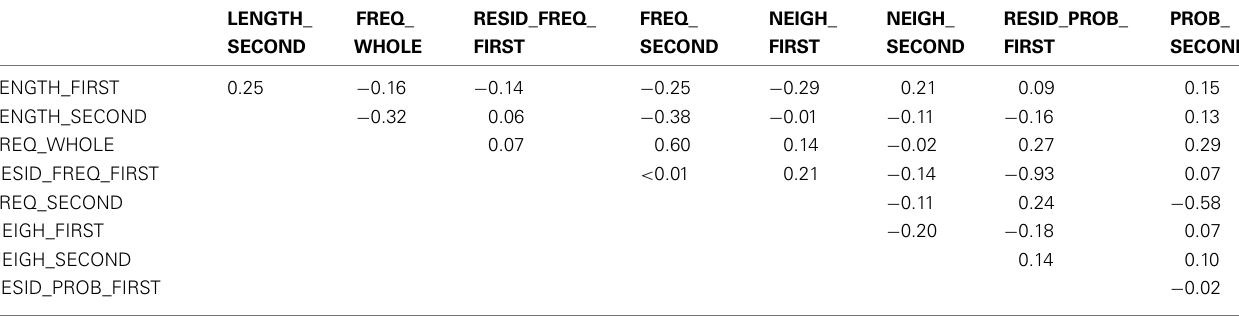
TableA4 | Correlation matrix of predictors used in IB analysis after residualization (values indicate pairwise Pearson